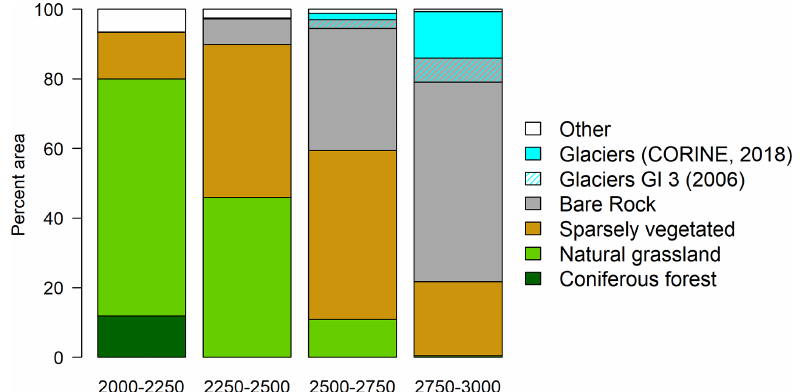
Figure 9. Land cover in the elevation bands between 2000 and 3000m a.s.l. based on CORINE land cover data (Umweltbundesamt, 2018).